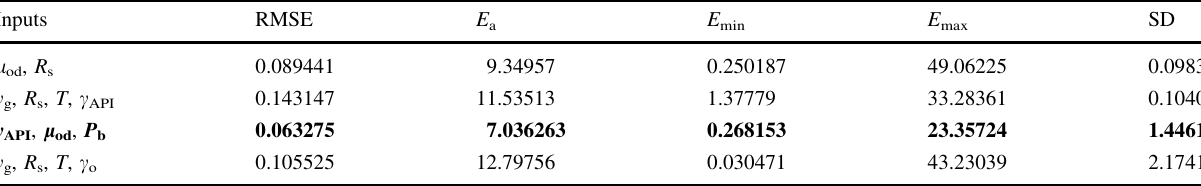
Table 7 Performance of the ensemble SVR for the functional forms for l ob